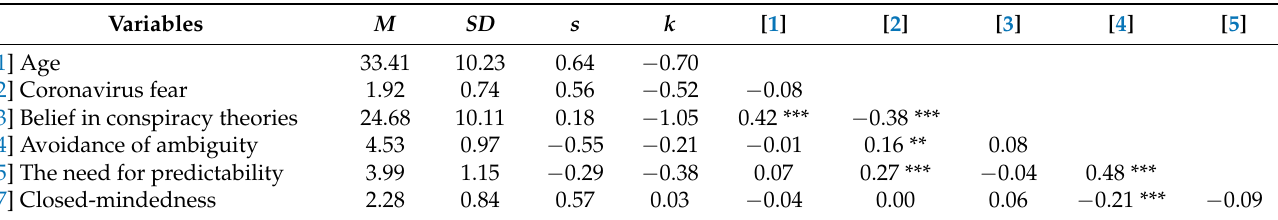
Table 1. Descriptive statistics and correlation between variables ( n = 380).